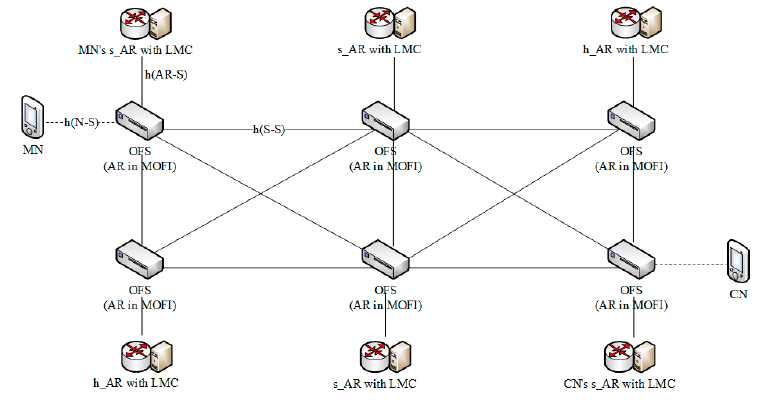
Figure 4. Topology for analyzing the cost model.